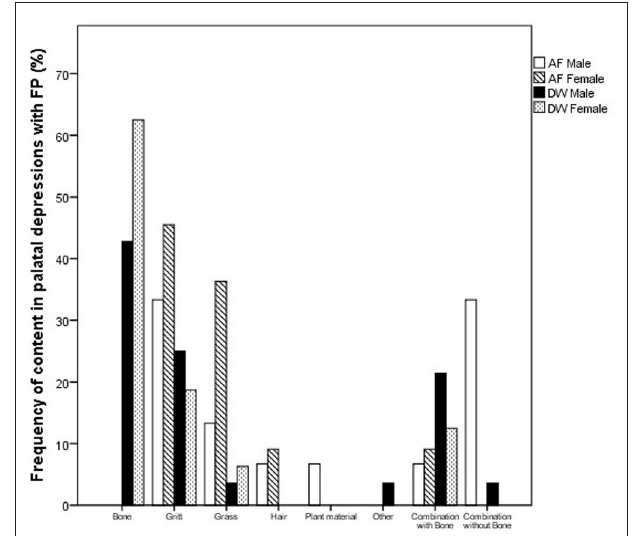
FIGURE 6 | Bar chart depicting the frequency (%) of different material found in the palatal depressions of cheetahs with FP between the two facilities (AF, AfriCat; DW, The Ann van Dyk Cheetah Centre).